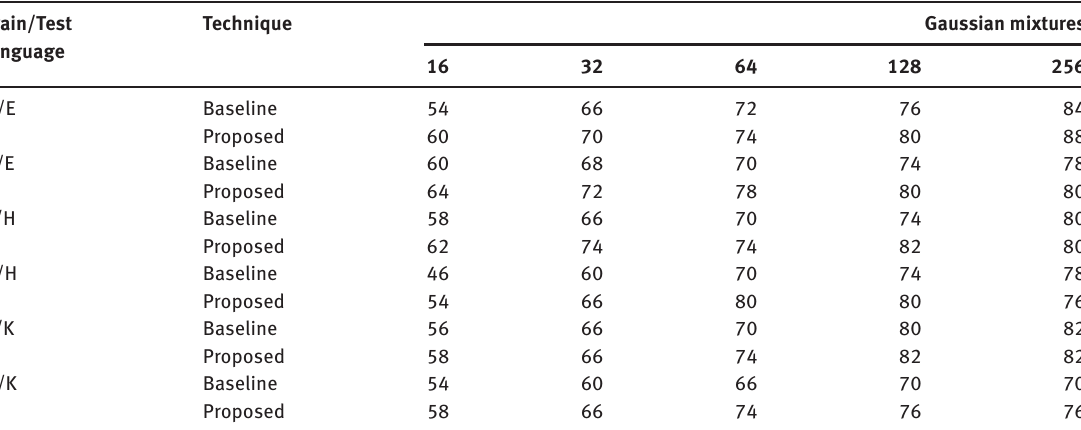
Table 6: Crosslingual Speaker Identification Performance (%) for the 50 Speakers of Our Own Database Using 20-s Training and Testing Data for Baseline (Multitaper MFCC-GMM-UBM) and Proposed